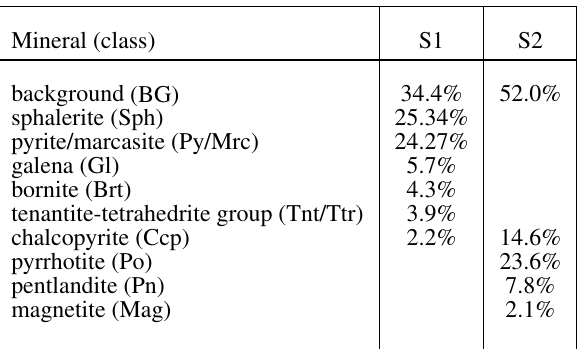
Table 1. Percentage of pixels per class in LumenStone dataset. S1 subset of LumenStone consists of 59 train and 16 test im- ages corresponding to the association of hydrothermal ore of Berezovskoe deposit. Together with background this subset contains 7 classes of minerals: background (BG), sphalerite (Sph), pyrite/marcasite (Py/Mrc), galena (Gl), bornite (Brt), tenantite-tetrahedrite group (Tnt/Ttr) and chalcopyrite (Ccp). S2 subset of LumenStone consists of 23 train and 6 test images corresponding to association of Layered Ultramafic Deposits (Deposits of the Norilsk Group). Together with background this subset contains 5 classes of minerals: background (BG), pyrrhotite (Po), chalcopyrite (Ccp), pentlandite (Pn) and mag- netite (Mag). Although S2 subset was collected, annotated and published, in this work we do not use it for training the pro- posed CNN model due to limited resources.